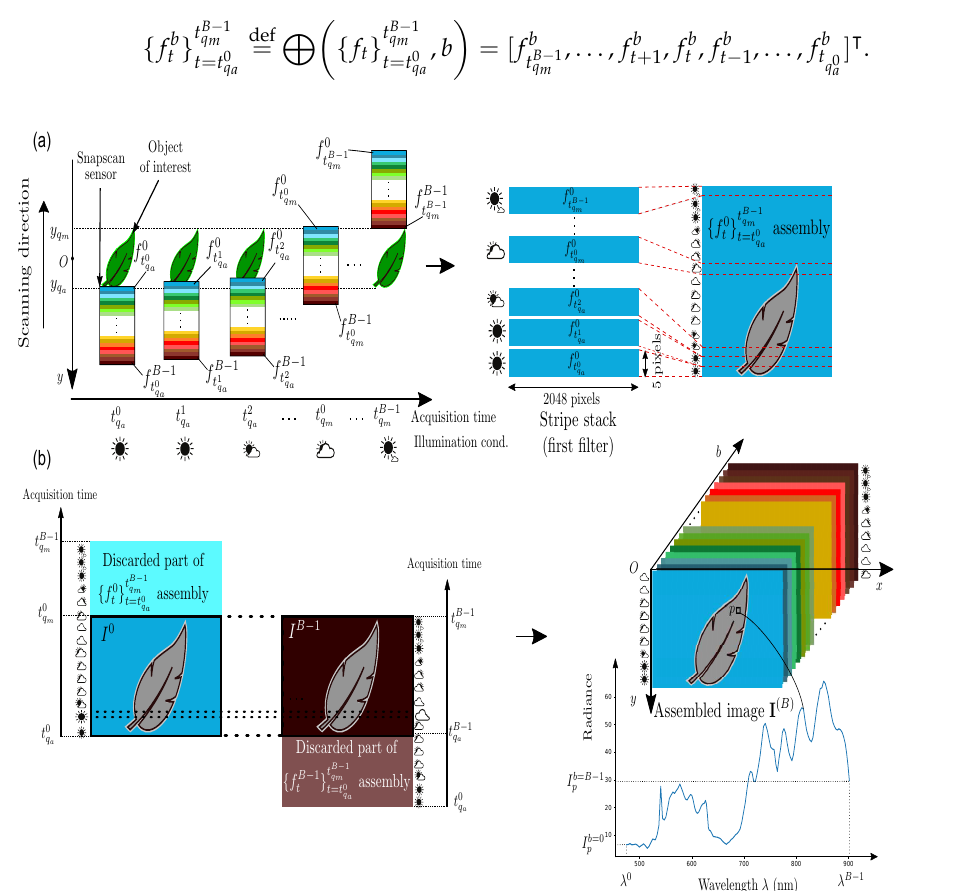
Figure 2. Frame acquisition and stripe assembly for channel I 0 ( a ) and multispectral image with B spectral channels ( b